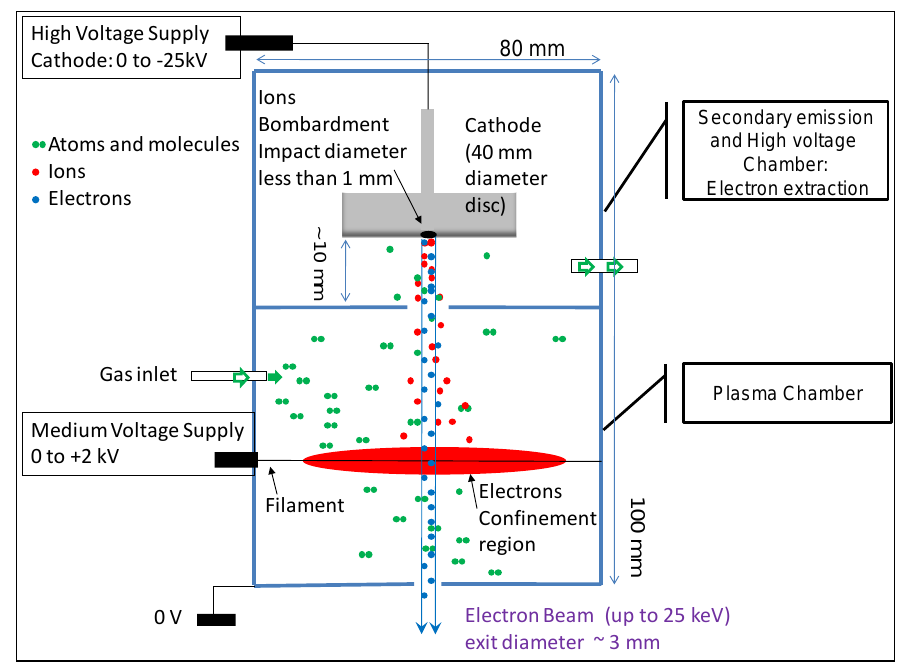
Figure 1. Electron beam emission